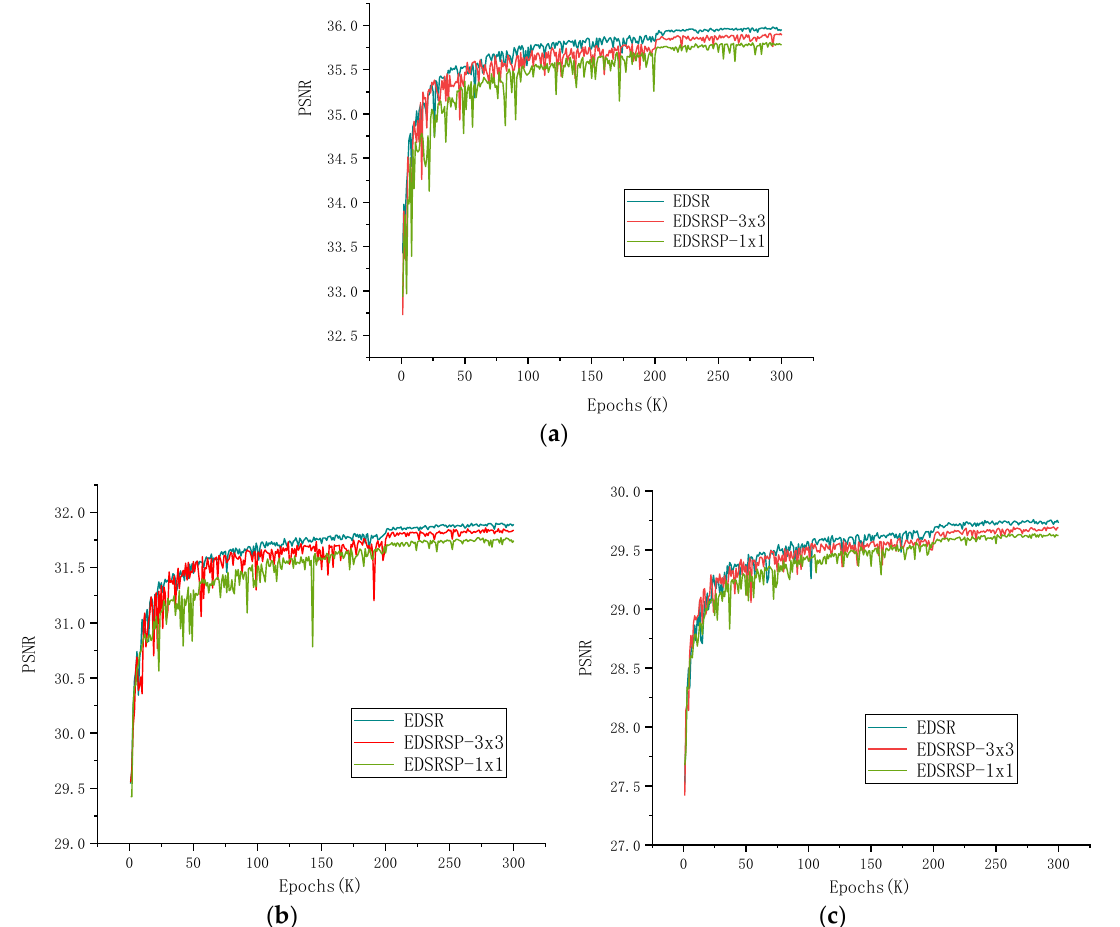
Figure 6. ( a ) Validation PSNR of EDSR × 2 model and proposed × 2 models. ( b ) Validation PSNR of EDSR × 3 model and proposed × 3 models. ( c ) Validation PSNR of EDSR x4 model and proposed × 4 models.